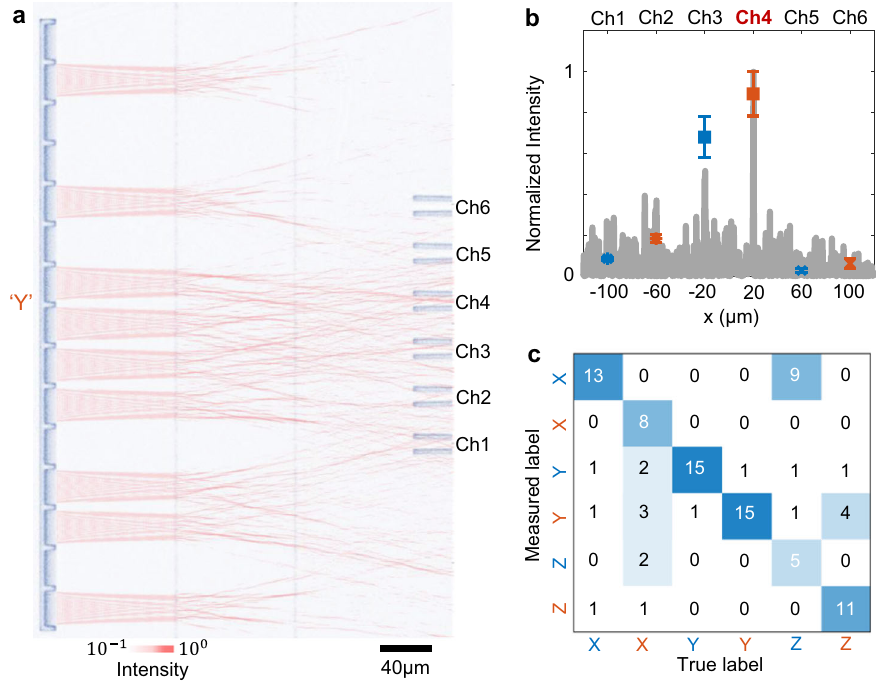
Fig. 5 On-the- fl y hyperspectral image classi fi er. a The simulated in-plane light distribution with the input pattern “ Y ” at 1570 nm is superimposed on the optical image of a fabricated device. b Measured signals on 6 channels for the same input as a (squares with error bars), compared to the simulated distribution at the output plane. The error bars represent the s.d. for 16 measurements. c The confusion matrix of the experimental results. Blue and red letters indicate the incident wavelength of 1530 nm and 1570 nm,